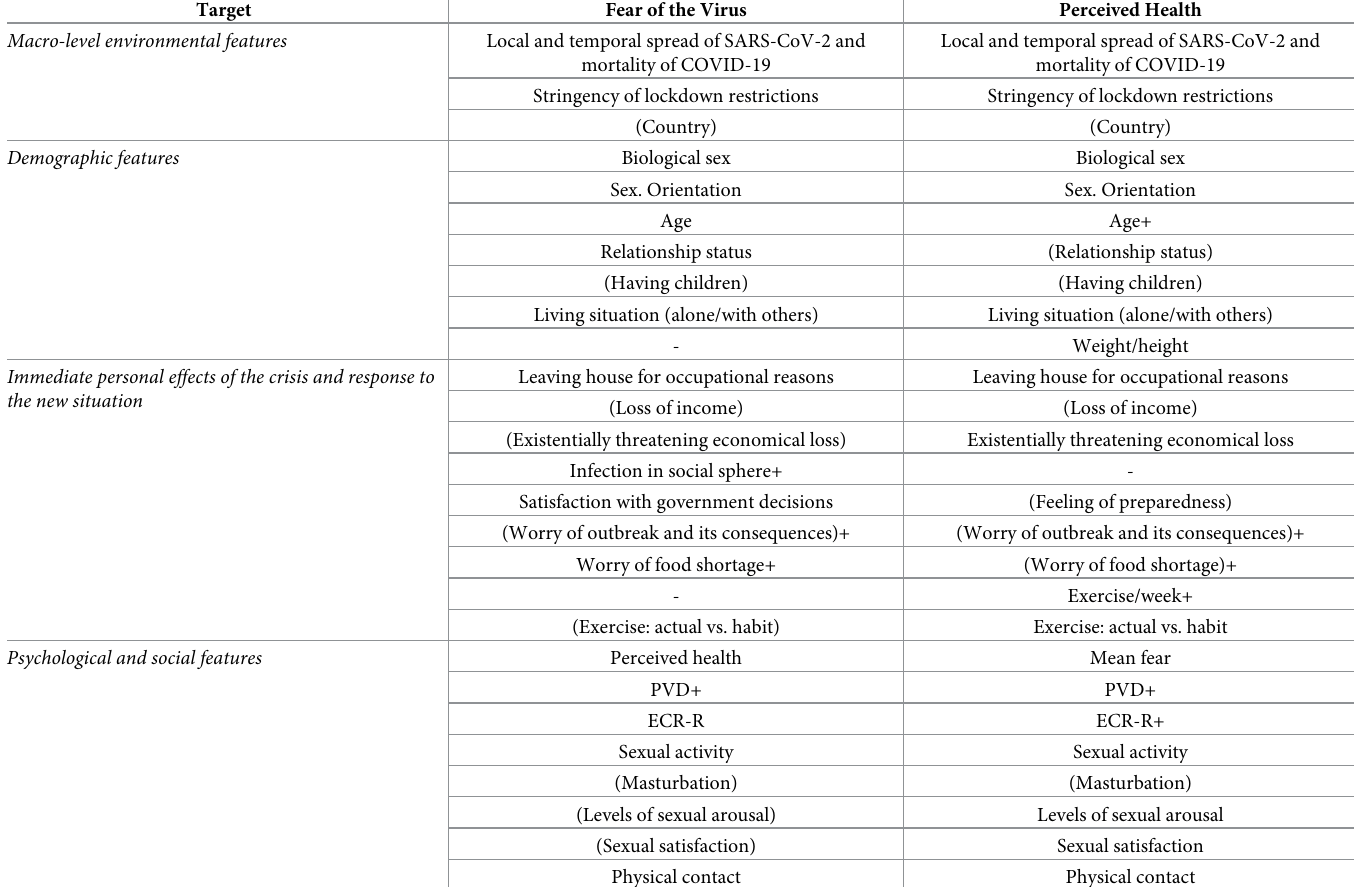
Table 1. Features included in machine learning models to predict the targets ‘fear’ and ‘perceived